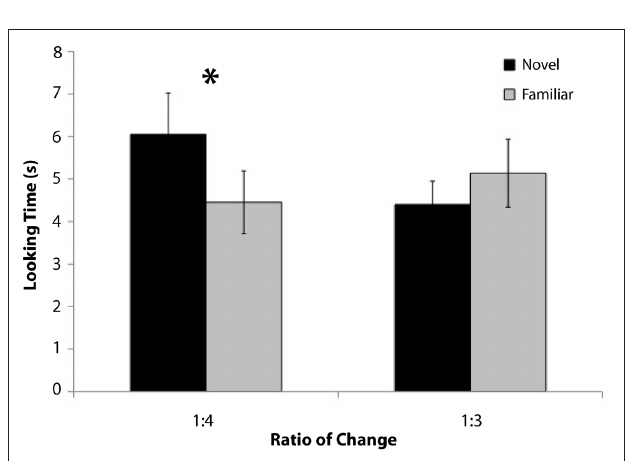
Figure 1 | Sample stimuli from experiment 1a. Throughout habituation, the number of items in each display varied sixfold, however the size of the items remained constant. In test, infants saw displays with the same item size and displays with items that changed in size fourfold from habituation (Test A – item size decrease; Test B – item size increase).